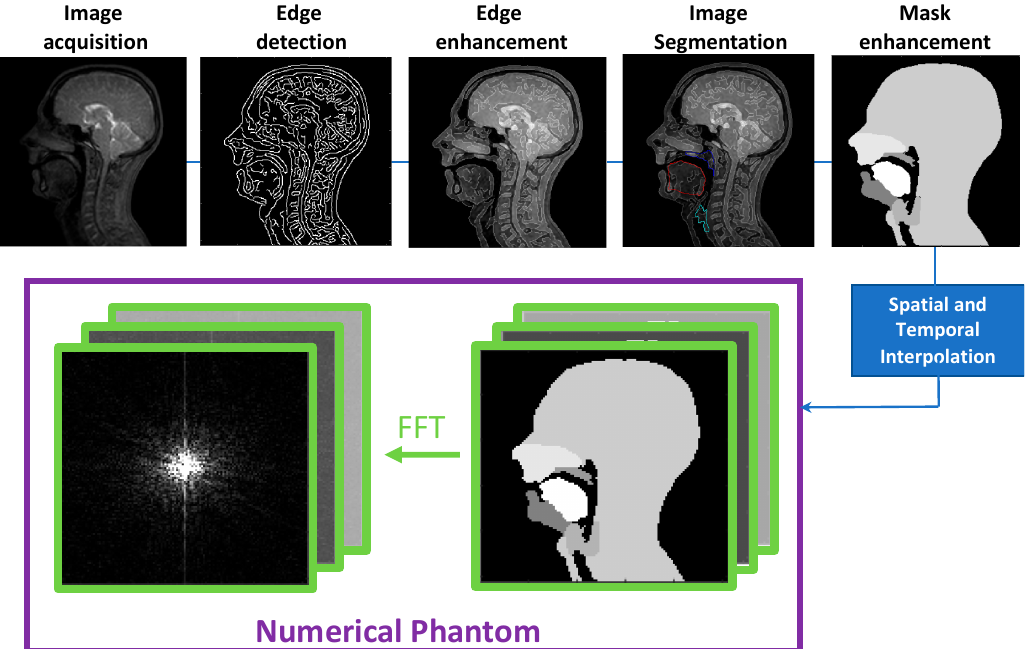
Figure 2. Software development framework used to develop the dynamic numerical phantom. The phantom is developed in image space from a real-time MRI video of a healthy volunteer acquired while speaking. The k-space numerical phantom is obtained by applying a fast Fourier transform (FFT) to the image domain numerical simulation.